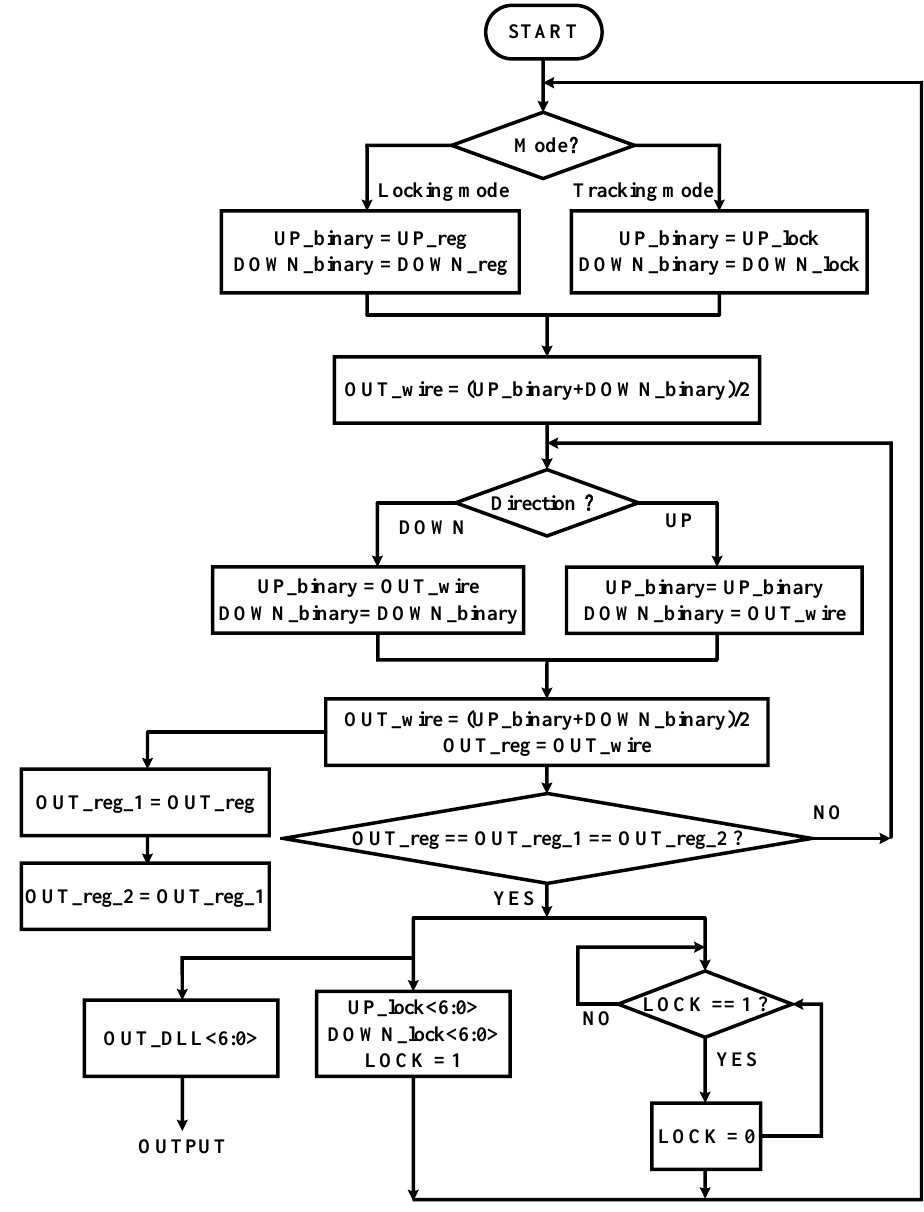
Figure 12. The flow chart of the proposed modified binary search algorithm.